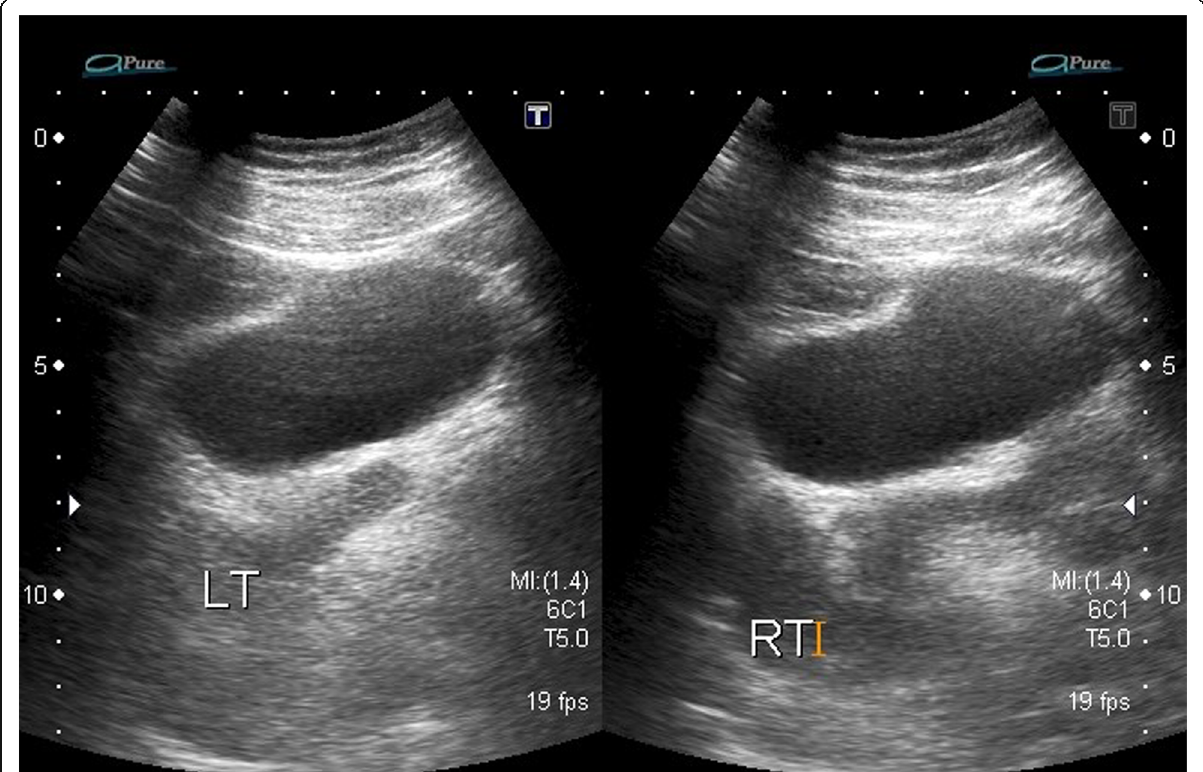
Fig. 1 US images of the pelvis showing a lobulated cystic lesion with rather clear contents and posterior enhancement arising from the right seminal vesicle measuring about 6 × 6 × 8 cm in its maximum dimensions and indenting the UB and prostate; otherwise, the normal sonographic appearance of the